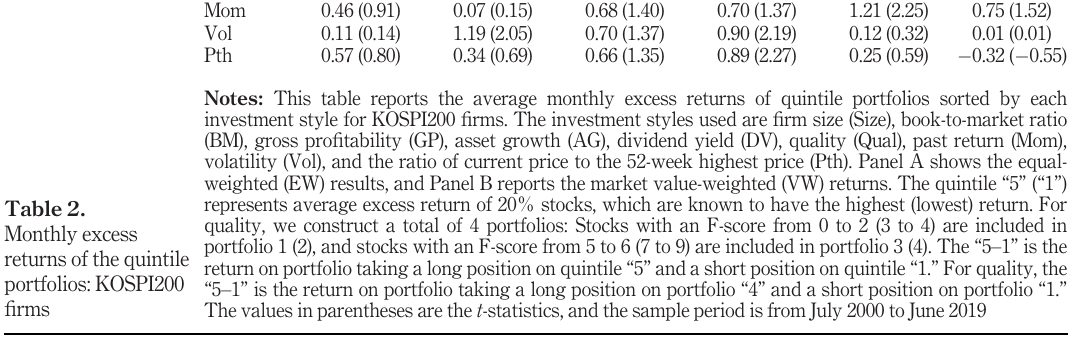
returns of the quintile portfolios: KOSPI200 fi